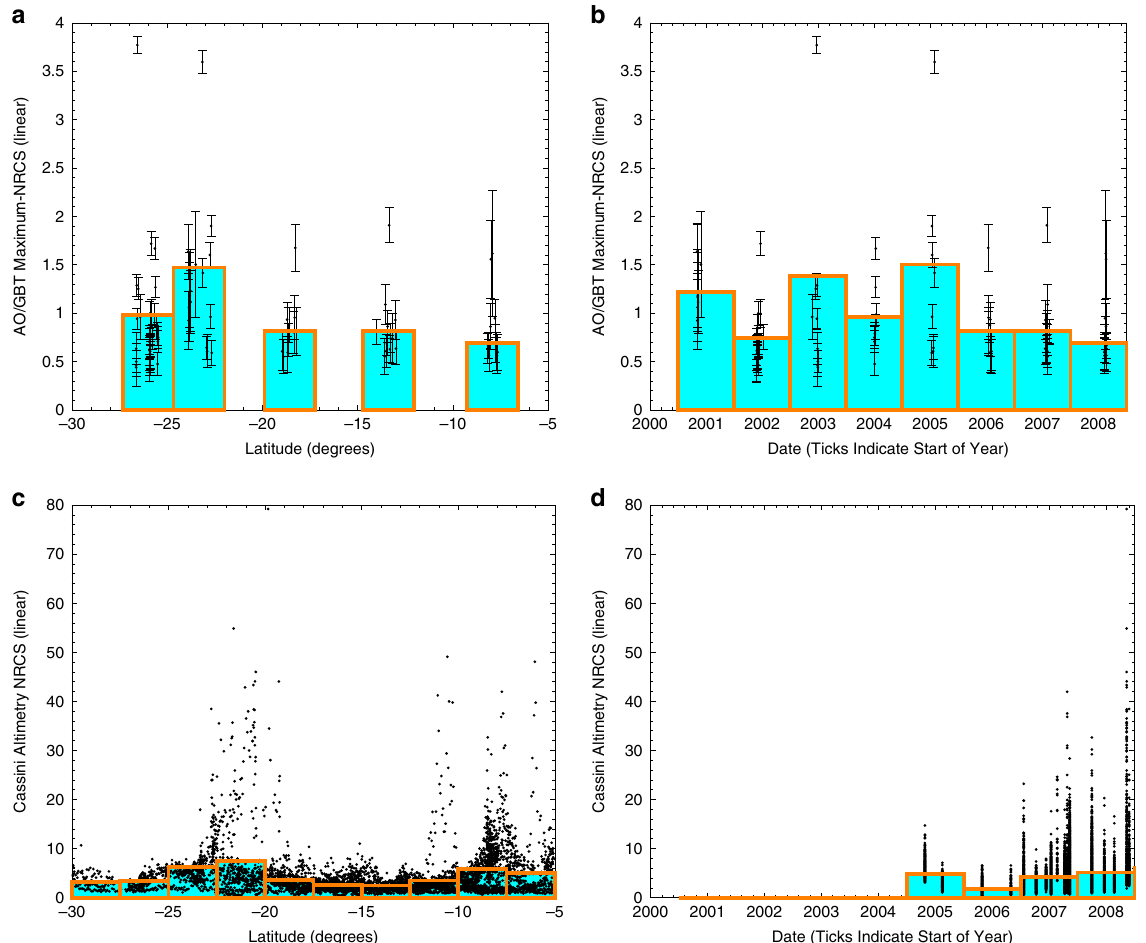
Fig. 3 NRCS as a function of latitude and date for AO/GBT and Cassini altimetry observations. Panels a , b show AO/GBT observations, like Fig. 19 of Black et al. 2 but the y -axis variable is maximum-NRCS. Panels c , d show Cassini altimetry observations. Panels a , c show latitude and panels b , d show date. Black dots are observations and orange-edged, cyan- fi lled rectangles are weighted means of the bins. Error bars show one standard deviation of the noise. There is an approximately consistent peak of the cyan/orange bins at ≈ 23°S between AO/GBT and Cassini and the latitude trends are somewhat similar. There is no agreement in the trends with date. Thus, the anomalously specular AO/GBT observations depend on location, not